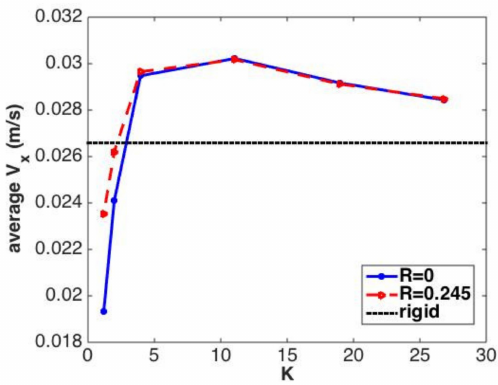
Figure 7. Average velocity in travelling direction with different stiffness and damping